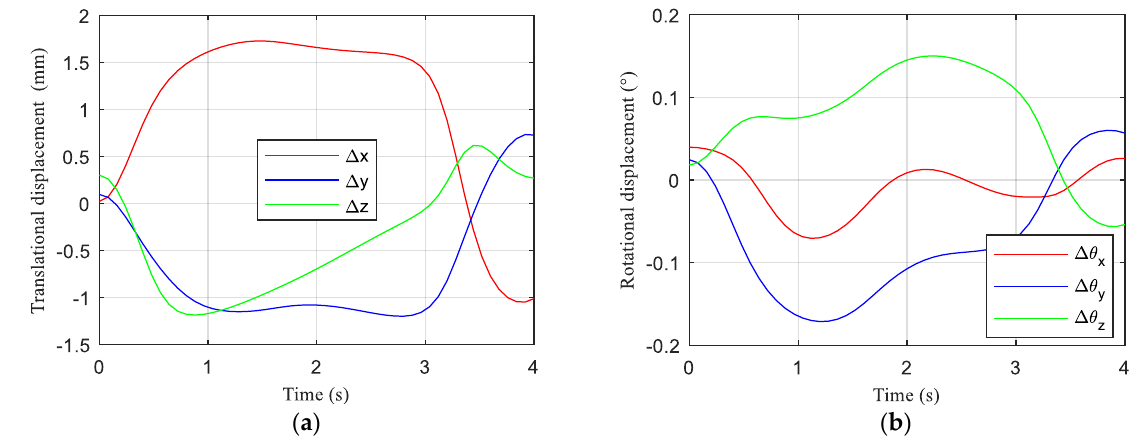
Figure 10. The real-time MSI of the humanoid manipulator.